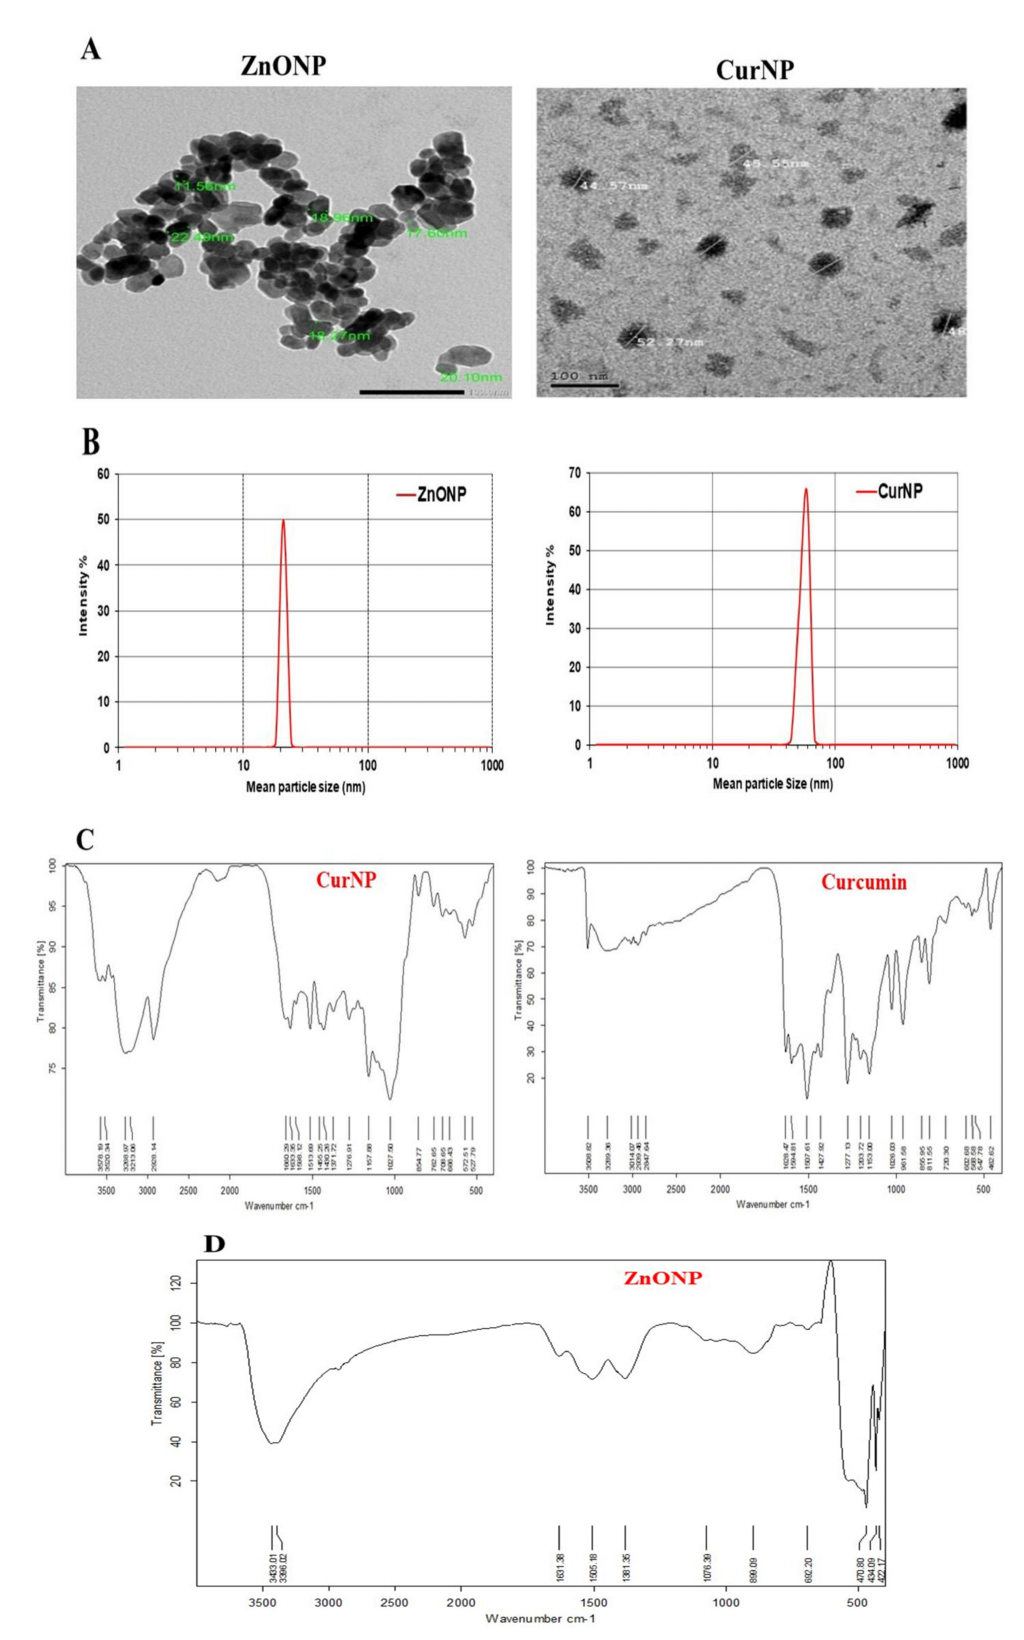
Figure 1. Characterization of ZnONP and CurNP. ( A ) TEM analysis of nanoparticles. ( B ) The particle size of nanoparticles. ( C ) FTIR analysis of curcumin and CurNP. ( D ) FTIR analysis of